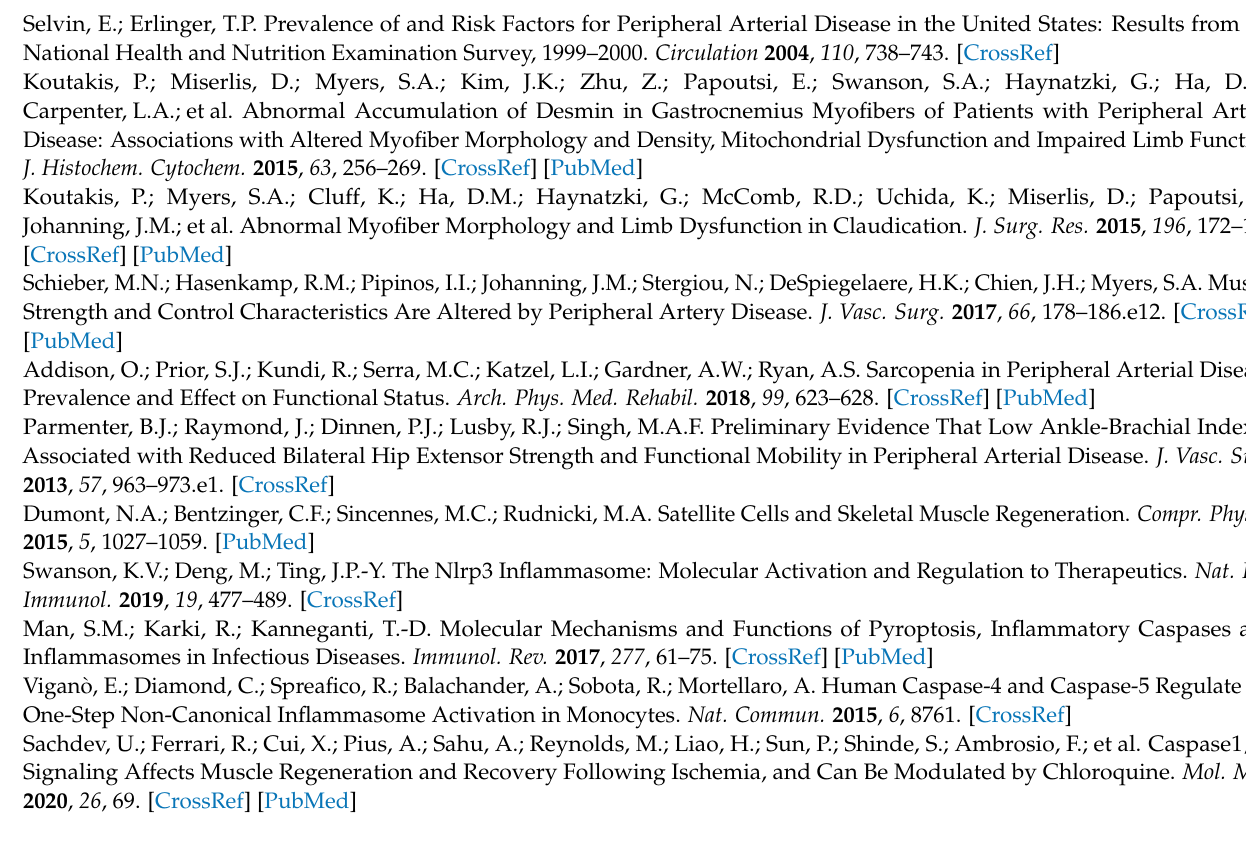
Figure S2: Caspase-1 expression was elevated in patients with intermittent